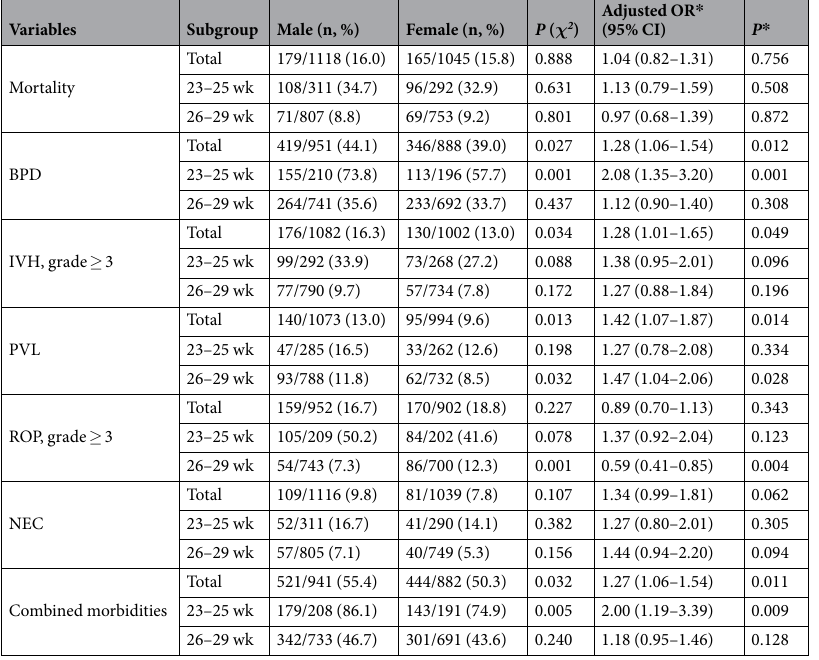
Table 3. Sex difference for the occurrence of mortality and the prevalence of major neonatal morbidities, stratified by gestational age group. * Values are odds ratio and 95% confidence interval. Values are adjusted by gestational age, histologic chorioamnionitis, intrauterine growth restriction, maternal diabetes, maternal hypertension, multiple births, delivery mode, and the use of antenatal